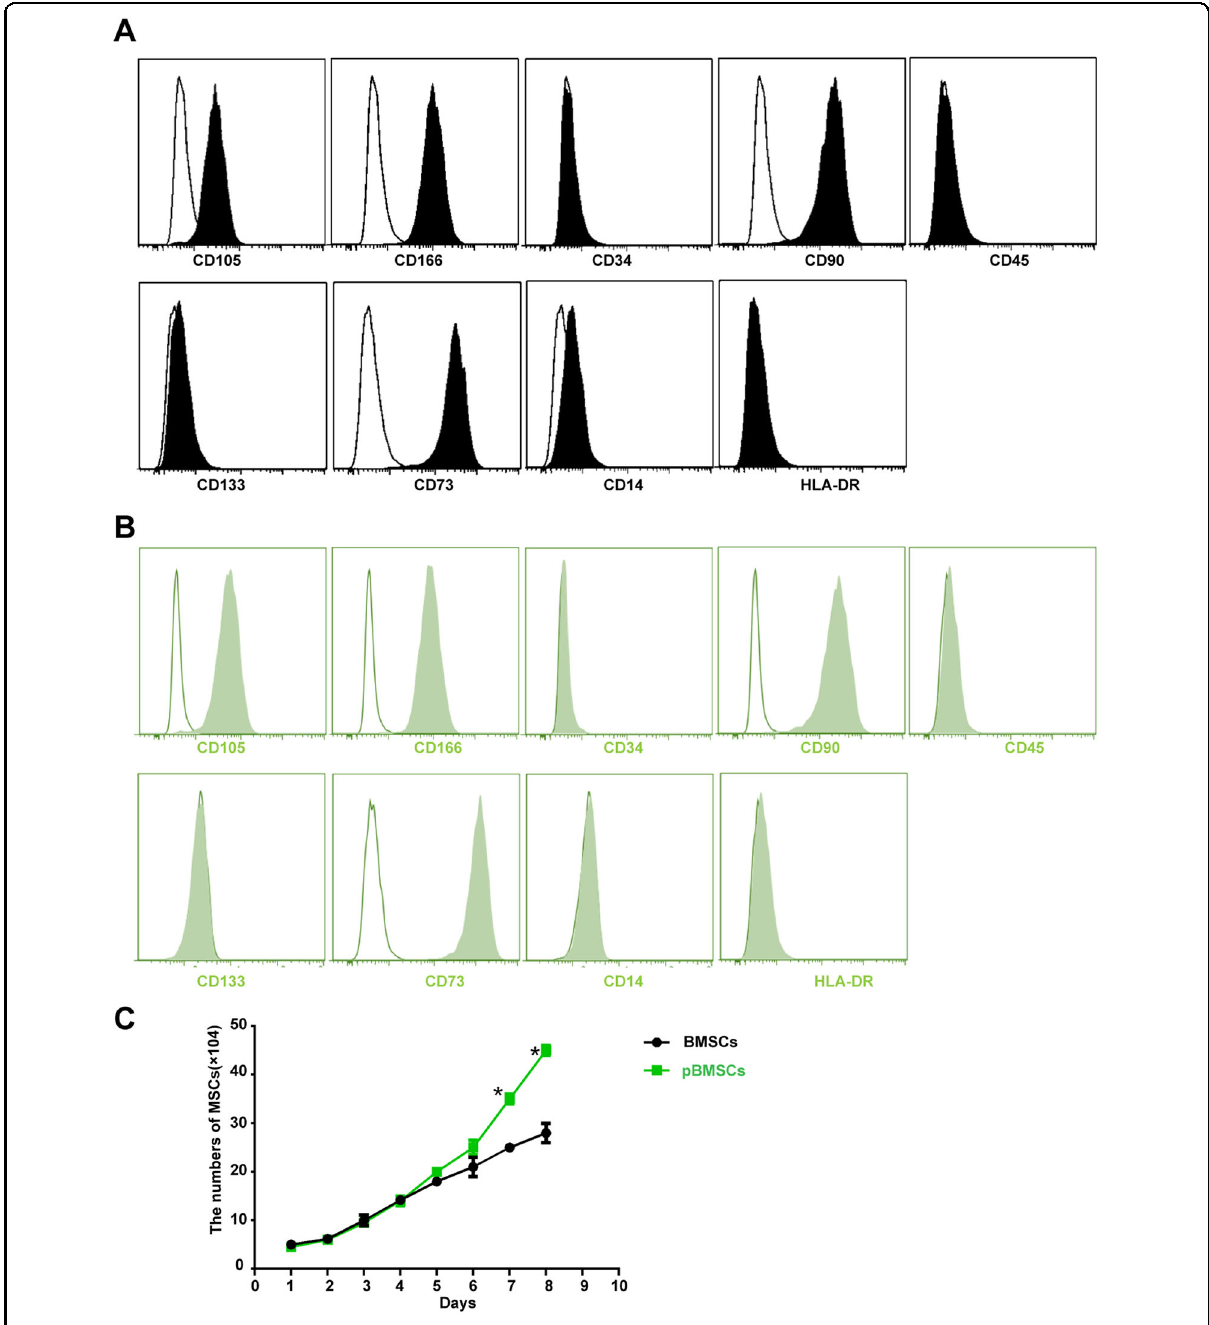
Fig. 1 Immune phenotypes and growth curves of the pBMSCs. Flow cytometric analysis of immune phenotypes of A MSCs from polydactyly tissue and B MSCs from bone marrow. The blank areas indicate the control, and the fi lled areas indicate the treated cells. C Growth curves of the pBMSCs and BMSCs cultured in vitro, * P <